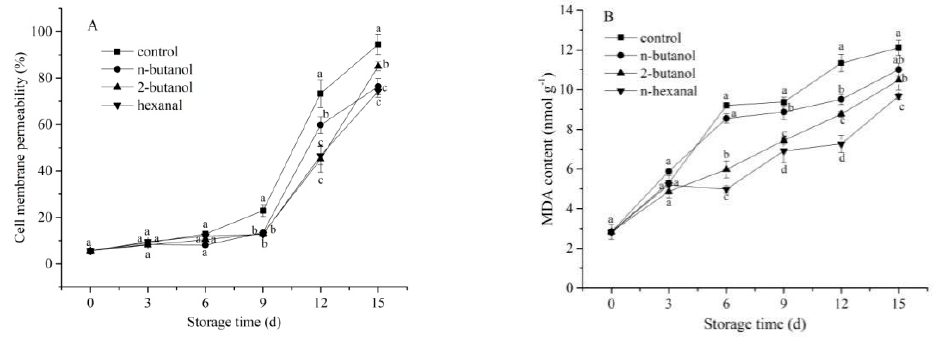
Figure 2. Effect of phospholipase D inhibitors treatment on cell membrane permeability ( A ) and MDA content ( B ) of postharvest banana fruit in response to mechanical wounding stress. The vertical bars in each mean indicate the standard error ( n = 3). Different letters among treatments at the same time point indicate significant differences ( p <